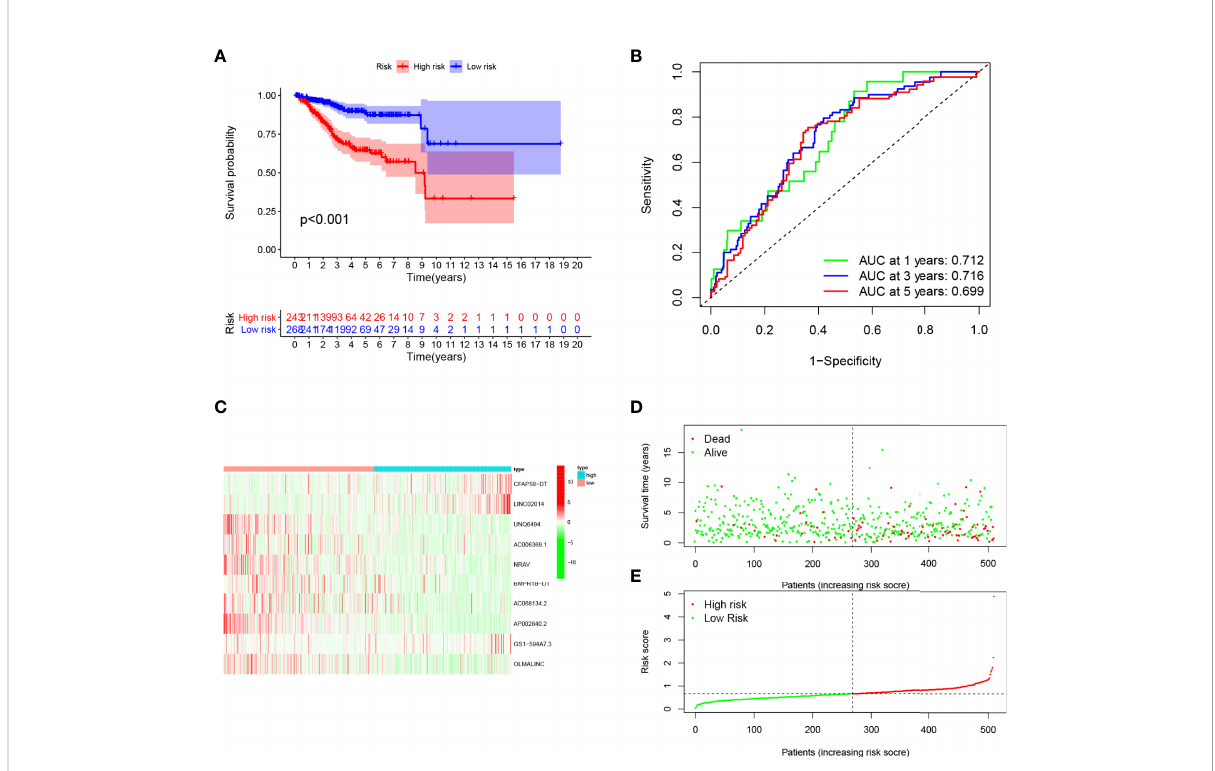
FIGURE 6 Evaluation of the prognostic value of this signature in entire cohort. (A) Survival analysis showed a worse prognosis in the high-risk group ( p < 0.001). (B) The 1, 3, and 5-year area under the curve (AUC) values of the signature are 0.712, 0.716, and 0.699, respectively. (C) Expression heatmaps of 10 lncRNAs in signature. (D, E) Survival status and risk score status of entire